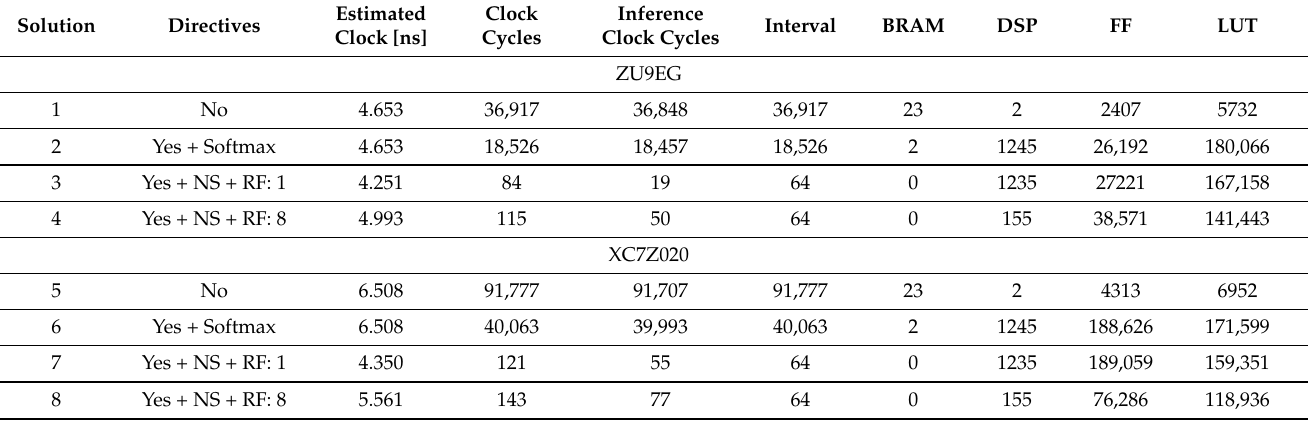
Table 2. HLS reports comparison. Solutions 1 and 5 without directives. Solutions 2 and 6 with directives applied by hls4ml and Softmax as activation function. Solutions 3 and 7 with directives applied by hls4ml, PIPELINE to improve the interval, without Softmax and with a reuse factor of 1 for all the layers. Solutions 4 and 8 with directives applied by hls4ml, PIPELINE to improve the interval, without Softmax and with a reuse factor of 8 for all the dense